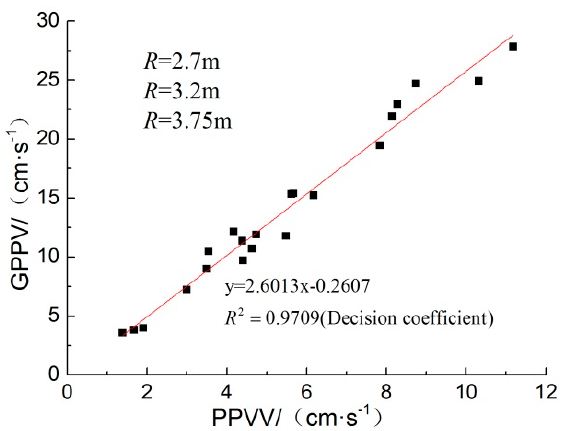
Figure 15. The relationship between GPPV and PPVV.